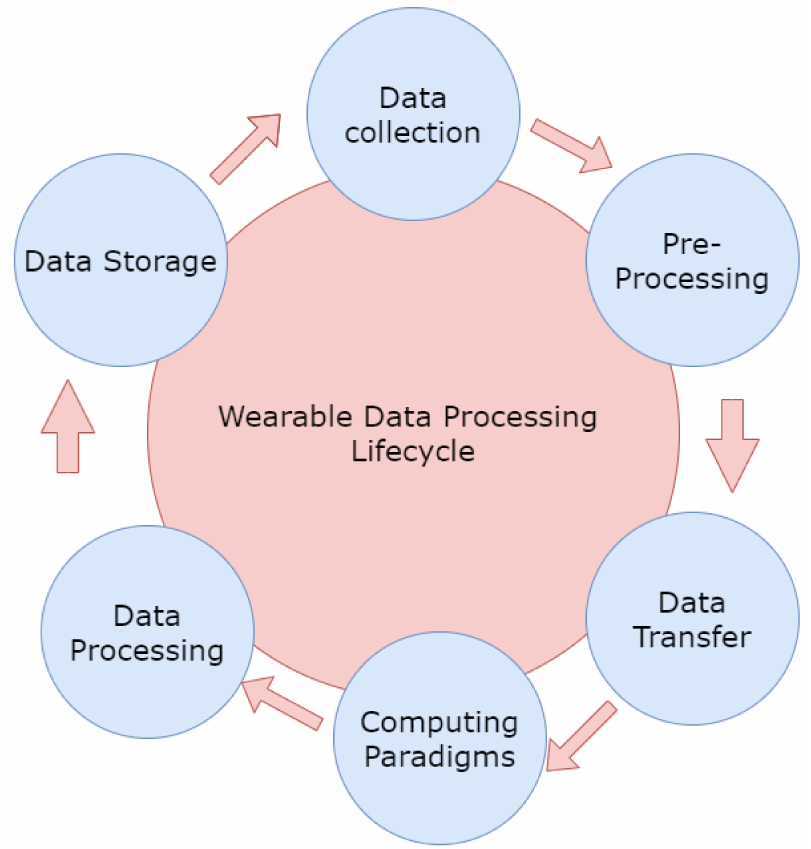
Figure 4. Data processing life cycle—IoT-assisted wearable sensor systems in